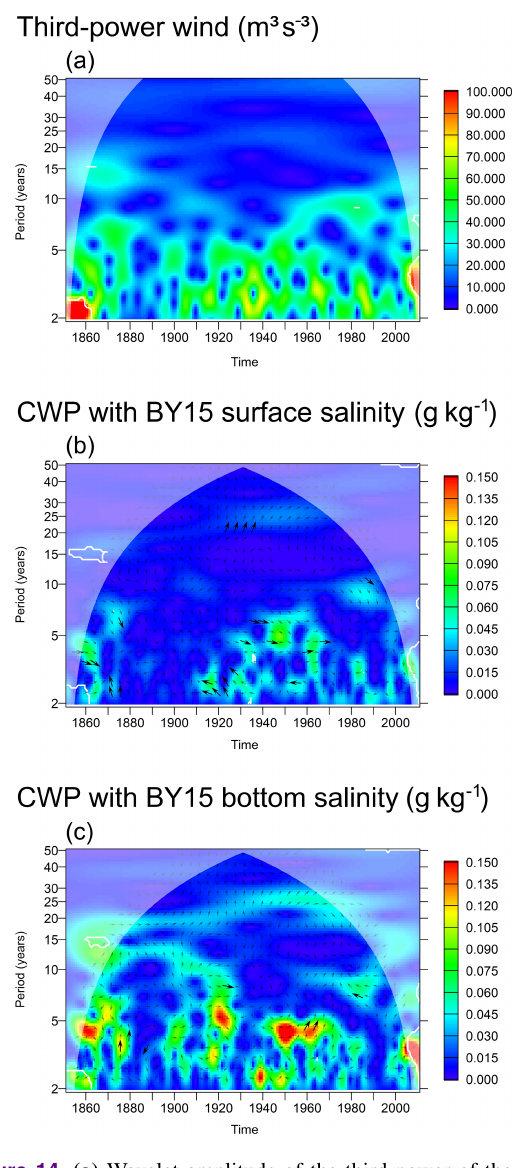
Figure 14. (a) Wavelet amplitude of the third power of the wind speed (m 3 s − 3 ). (b) Common wavelet power between modelled sur- face salinity and normalized third-power wind (g kg − 1 ). (c) The same for bottom salinity. All variables at station BY15 (Eastern Gotland Basin). White contours indicate that the WA or CWP is significant at the 95% confidence level with respect to a random shuffling of the annual means of the third-power wind. Arrows indi- cate relative phase: → : in phase; ↓ : third-power wind leading salin- ity by 90 ◦ . Thick arrows indicate phase stability (wavelet coherence >